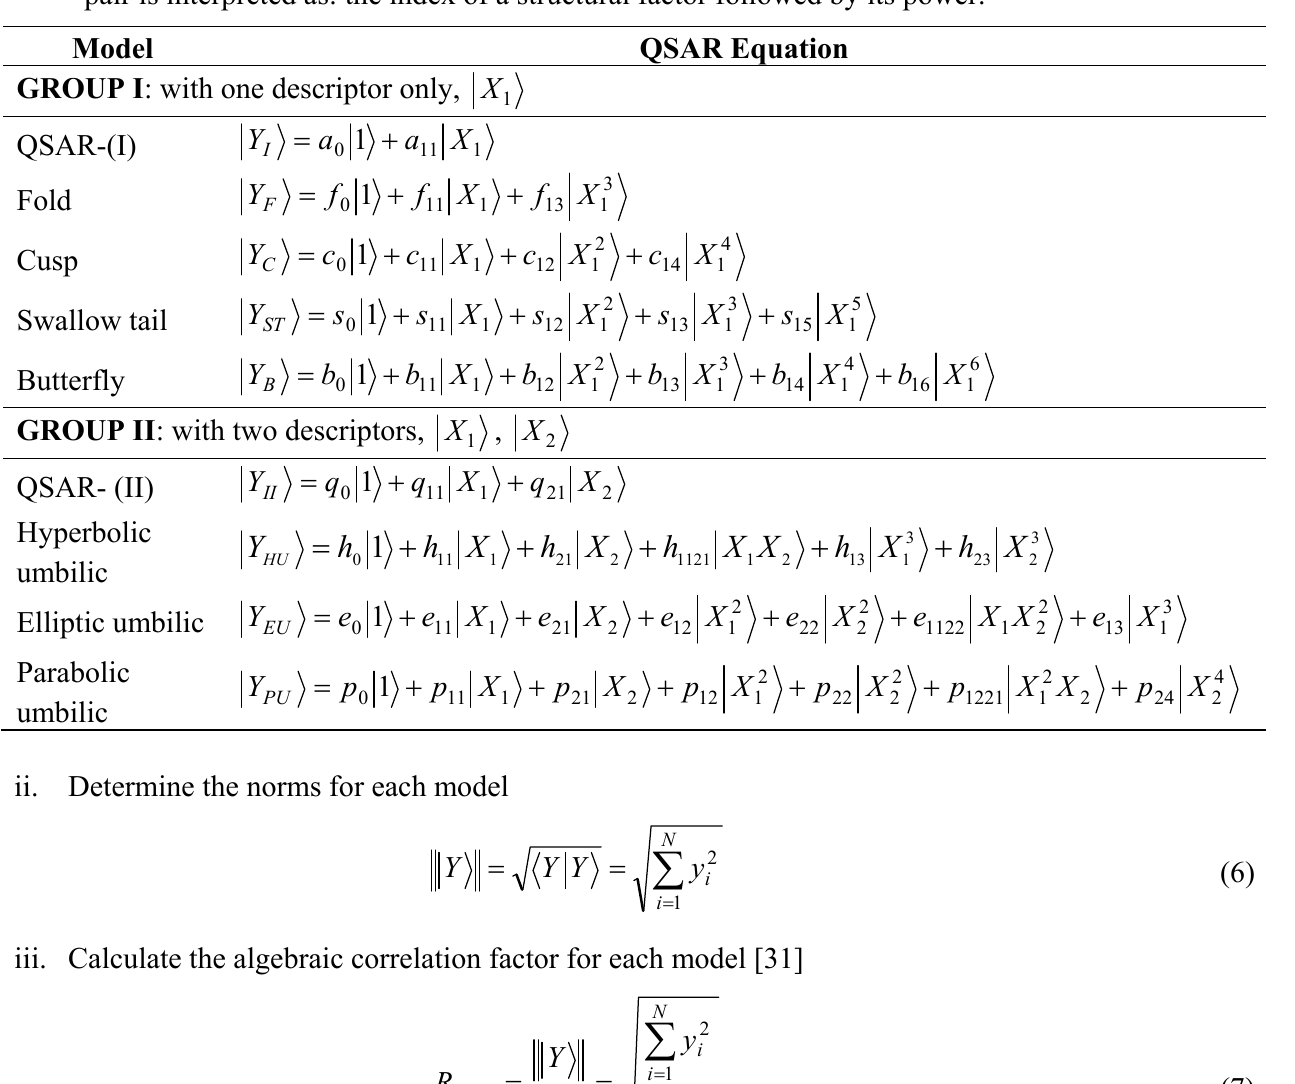
Table 3. Algebraic realization of Thom’s elementary catastrophes as uni- and bi- nonlinear QSARs. The systematics of the sub-indices indicate consecutive coupled pairs, where each pair is interpreted as: the index of a structural factor followed by its